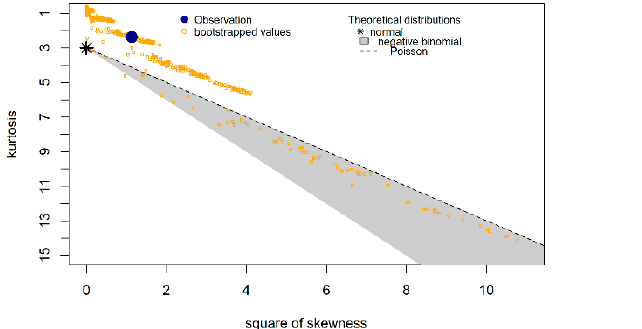
Figure 1. Cullen and Frey graph of the H-Index of journals from LAC and other regions.